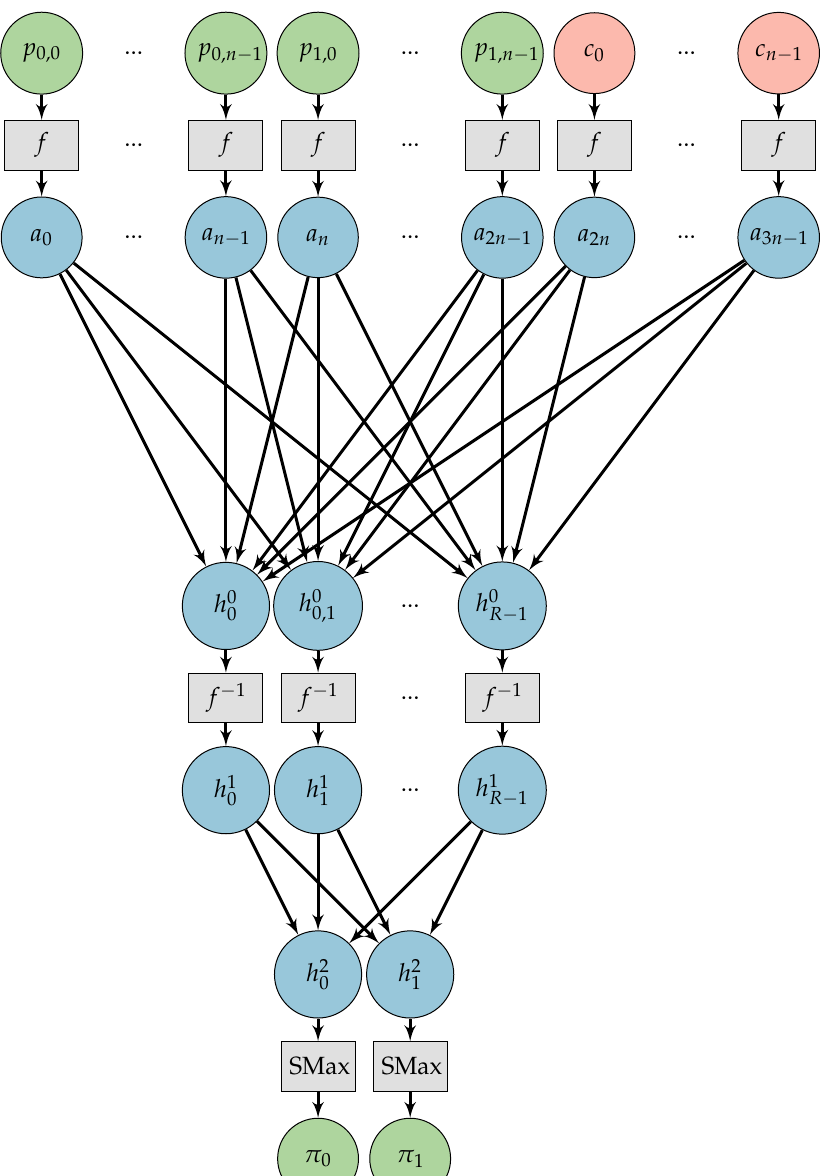
Figure 5. Eve’s neural network ( CPA-CryptoNet ). Eve receives as input two plaintexts P 0 and P 1 . The bits of each plaintext are represented by [ p 0,0 , ..., p 0, n − 1 ] for P 0 and [ p 1,0 , ..., p 1, n − 1 ] for P 1 . Eve also receives the ciphertext C represented by [ c 0 , ..., c n − 1 ]. The function f (see Equation (9)) transforms the bits into angles [ a 0 , a 1 , ... a 3 n − 1 ]. A fully connected layer combines the angles generating the hidden variables [ h 0 , h 0 , ..., h 0 ], where R is the number of rules. The function f − 1 (see Equation (10)) R − 1 0 1 transforms the combined angles into continuous bits (real numbers in the interval [ 0,1 ] ) [ h 1 h 1 ]. Another fully connected layer brings the hidden variables to logits through a softmax layer R − 1 resulting in a probability π 0 of C being a ciphertext of P 0 and a probability π 1 of C being a